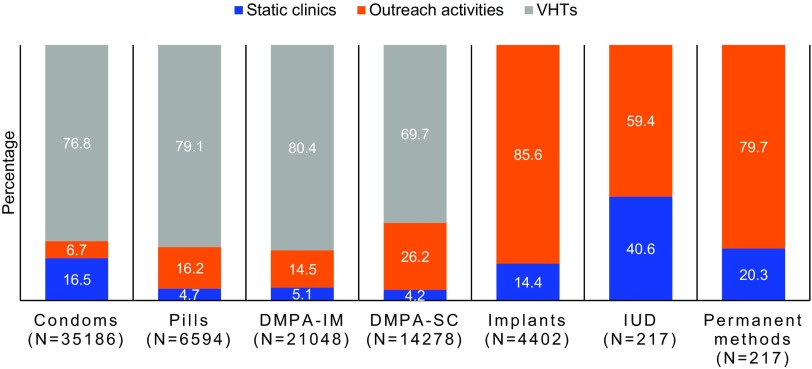
Percentage Distribution of Family Planning Methods by Service Delivery Channel, 4 Districts of Uganda, April 2016–March 2017Abbreviations: DMPA-IM, intramuscular depot medroxyprogesterone acetate; DMPA-SC, subcutaneous depot medroxyprogesterone acetate; IUD, intrauterine device; VHT, village health team.Note: Pills include combined oral contraceptives and progestin-only pills; condoms include male and female condoms; and permanent methods include tubal ligation and vasectomy.